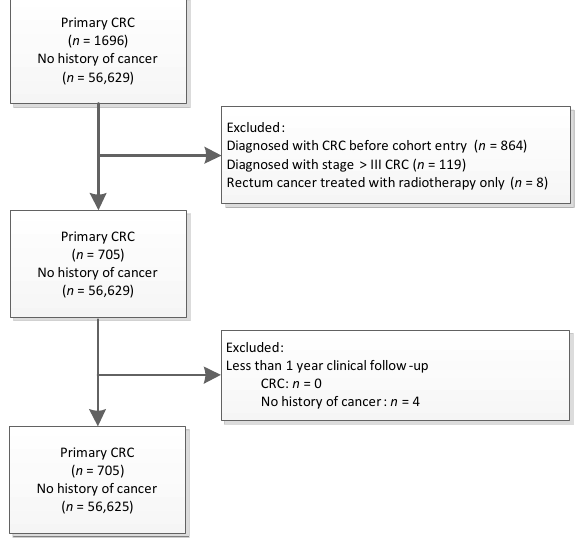
Figure 1. Study flow chart of patients included in the analysis.